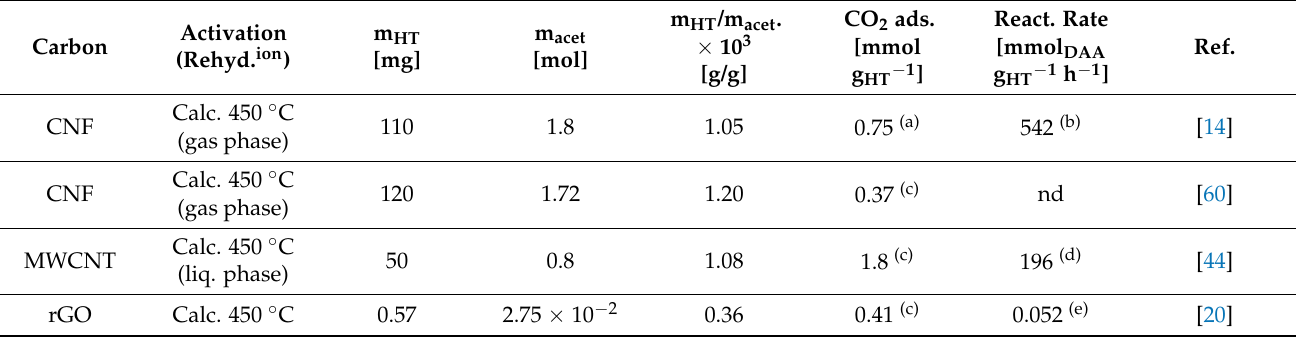
Table 3. Basicity and catalytic activity in the self-condensation of acetone at 0 ◦ C for different MgAl-LDH/carbon